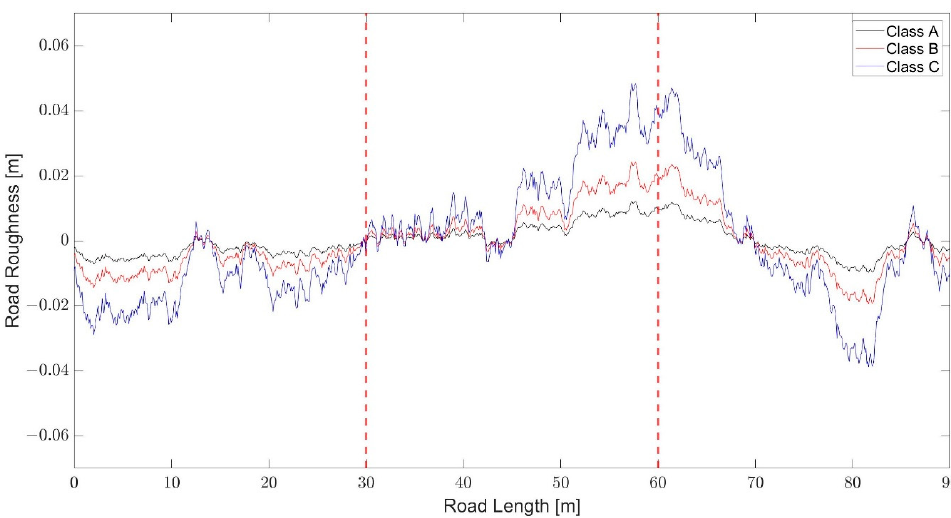
Figure 5. Simulated road roughness profiles corresponding to Class A, B, and C. The traffic induced vibration response of the bridge has been simulated for the three different road profiles and increasing noise levels (10%, 20%, and 30%) in order to assess the performance of output-only modal identification from indirect measurements characterized by different signal-to-noise ratio. Gaussian white noise was therefore added to the simulated time series to account for the effect of measurement noise. While the results were consistent independently of the road profile, the presence of noise limited the